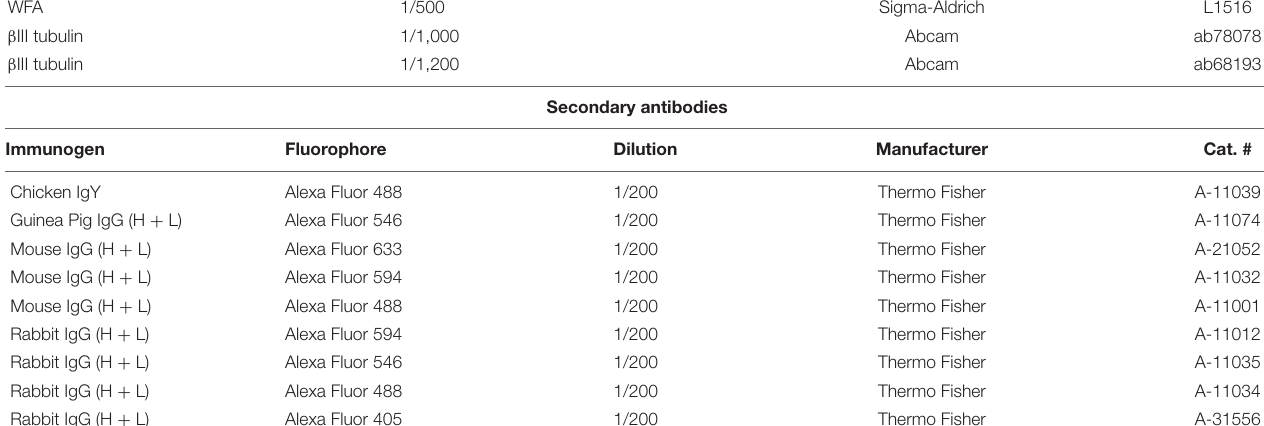
( Figure 5 ). The excitatory pre-synaptic marker, vesicular glutamate transporter 1 (VGLUT1), was colocalized with directing glutamate receptors. The largest shift in